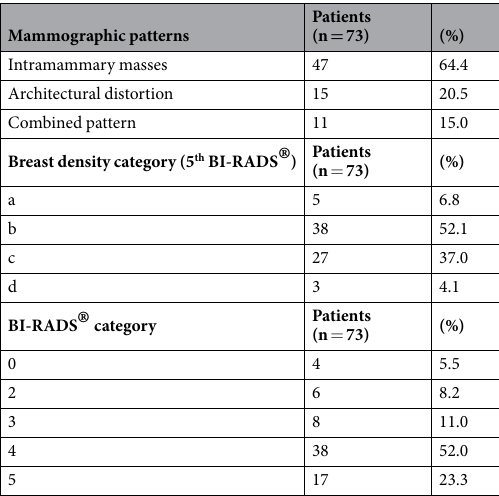
Table 3. Mammographic findings of intramamamary hematological malignancies